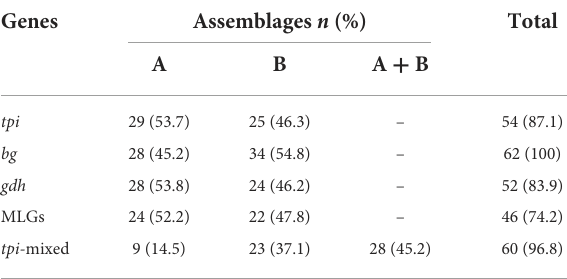
TABLE 3 Identification of assemblages A and B based on tpi , bg , and gdh loci, multilocus genotypes (MLGs) and mixed infection according to tpi A and B assemblage-specific